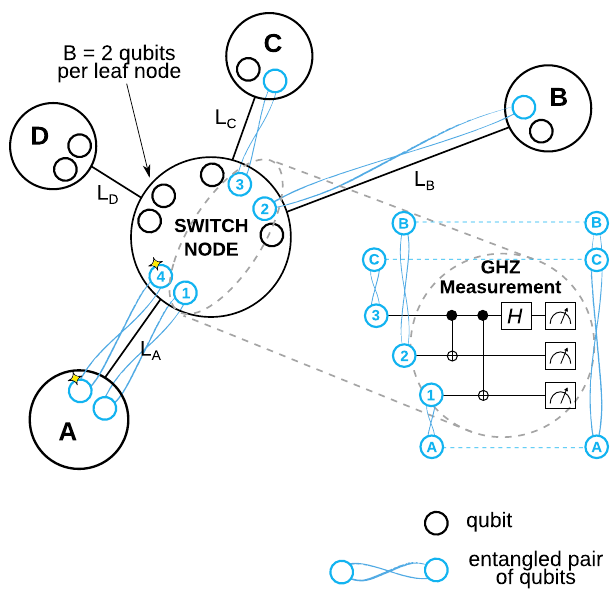
Fig. 3 A quantum switch in a star-shaped network topology as studied by Vardoyan et al. 56 . The switch (central node) is connected to a set of users (leaf nodes) via an optical fi bre link that distributes perfect Bell pairs at random times, following an exponential distribution with mean rate μ ∝ e − β L , where L denotes the distance of the link and β the attenuation coef fi cient. Associated with each link there is a buffer that can store B qubits at each side of the link. As soon as n Bell pairs with different leaves are available, the switch performs a measurement in the n -partite Greenberger – Horne – Zeilinger (GHZ) basis, which results in an n -partite GHZ state shared by the leaves. The GHZ-basis measurement consists of: fi rst, controlled-X gates with the same qubit as control; next, a Hadamard ( H ) gate on the control qubit; fi nally, measurement of all qubits individually. The fi gure shows four leaf nodes, GHZ size n = 3 and a buffer size B =